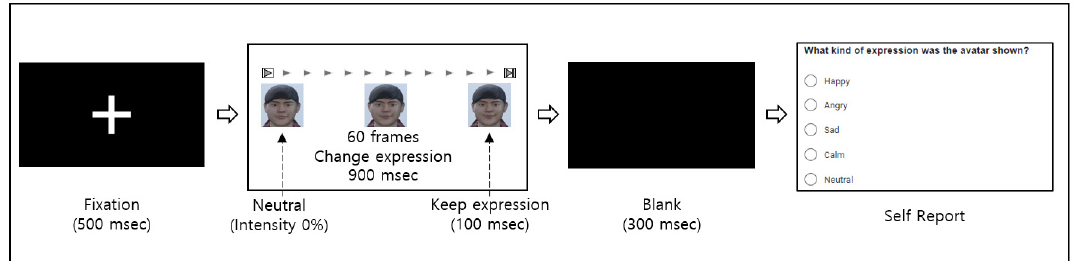
Figure 3. The experimental procedure for normalizing facial expression intensity .